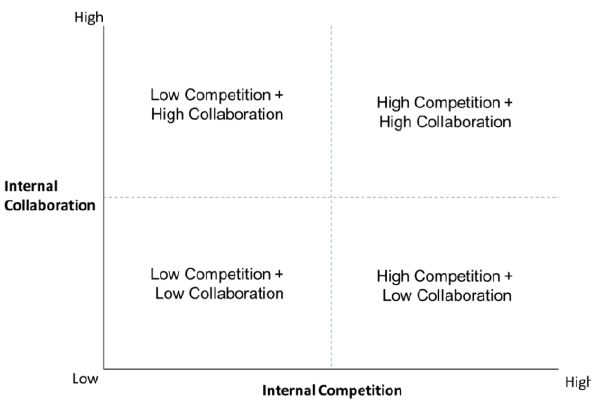
Figure 2: The management paradox model Social interdependence